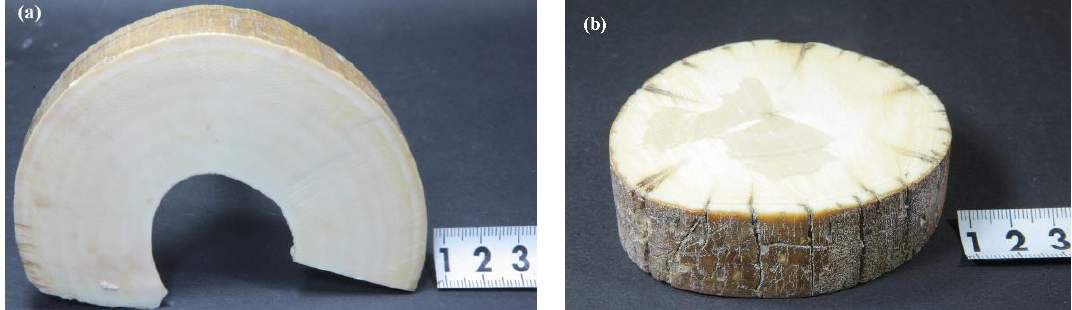
Figure 1. Representative specimen photographs of samples: ( a ) a sample of ivory from adult Zimbabwean elephants, light yellowish white, ( b ) a sample of mammoth ivory from mammoth in Russia (Siberia), deep yellowish white.